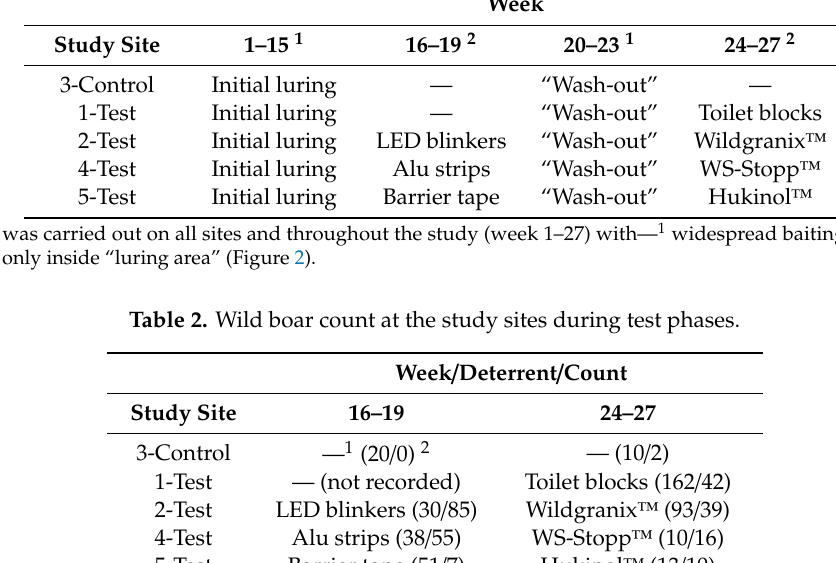
Table 1. Study plan for the five study sites (Figure 1).